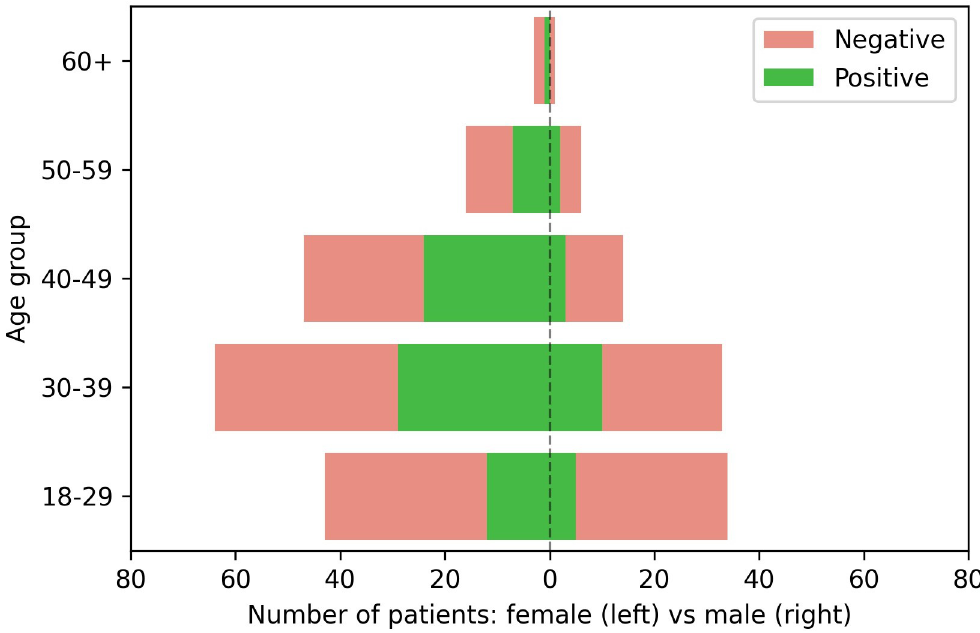
Fig 4. Pyramid combining diagnosis, gender (female: Left; male: Right), and age